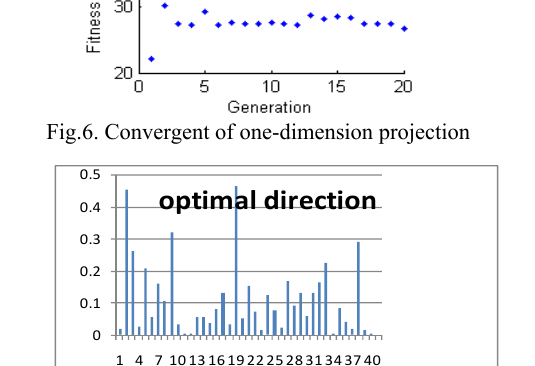
Fig.5. One-dimension projection for MI